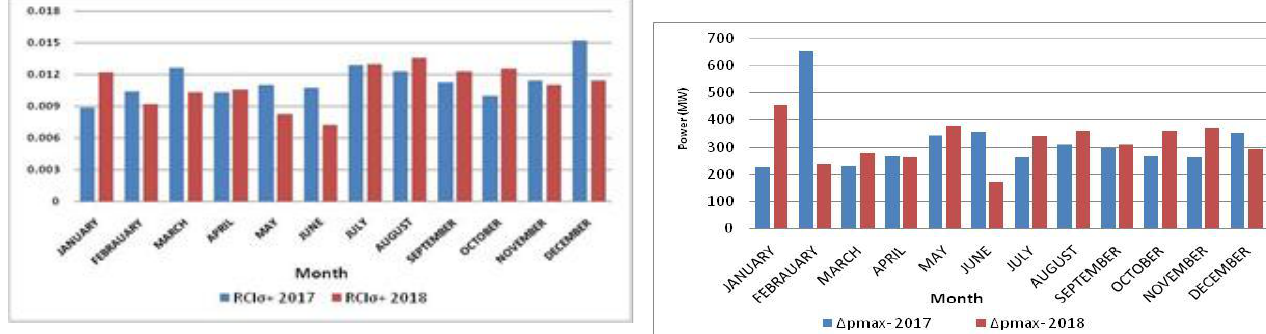
Figure 31. Comparison between RCIs for the standard deviation of upward power ramps in 15 min interval for each month for years 2017 and 2018.